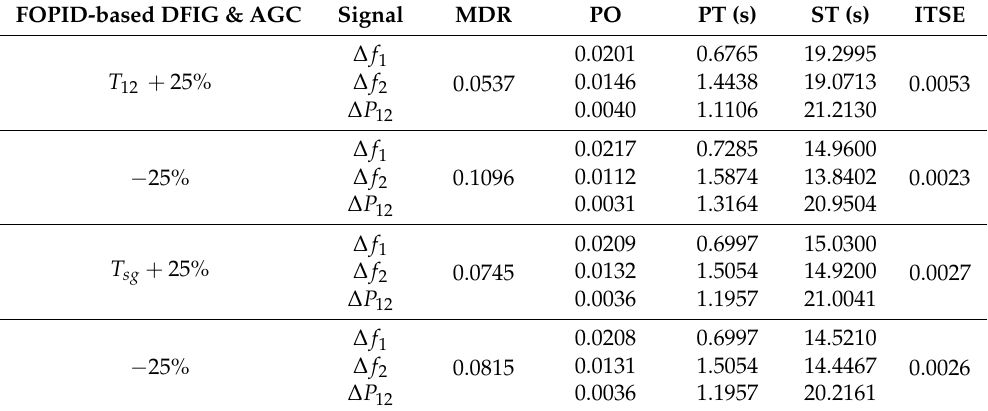
Table 4. Frequency deviation and tie-line power characteristics of FOPID controllers for ± 25% variations in the time constant of steam turbine and synchronizing